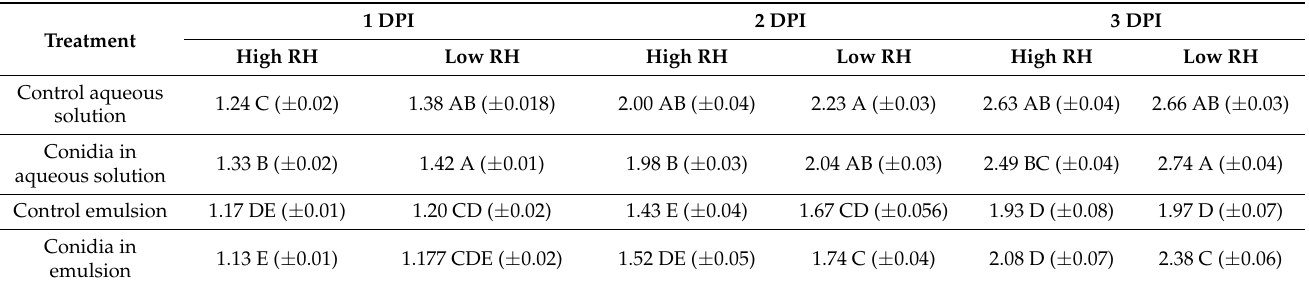
Table 4. Mean larval body length ( ± SE) in mm by treatment and RH.